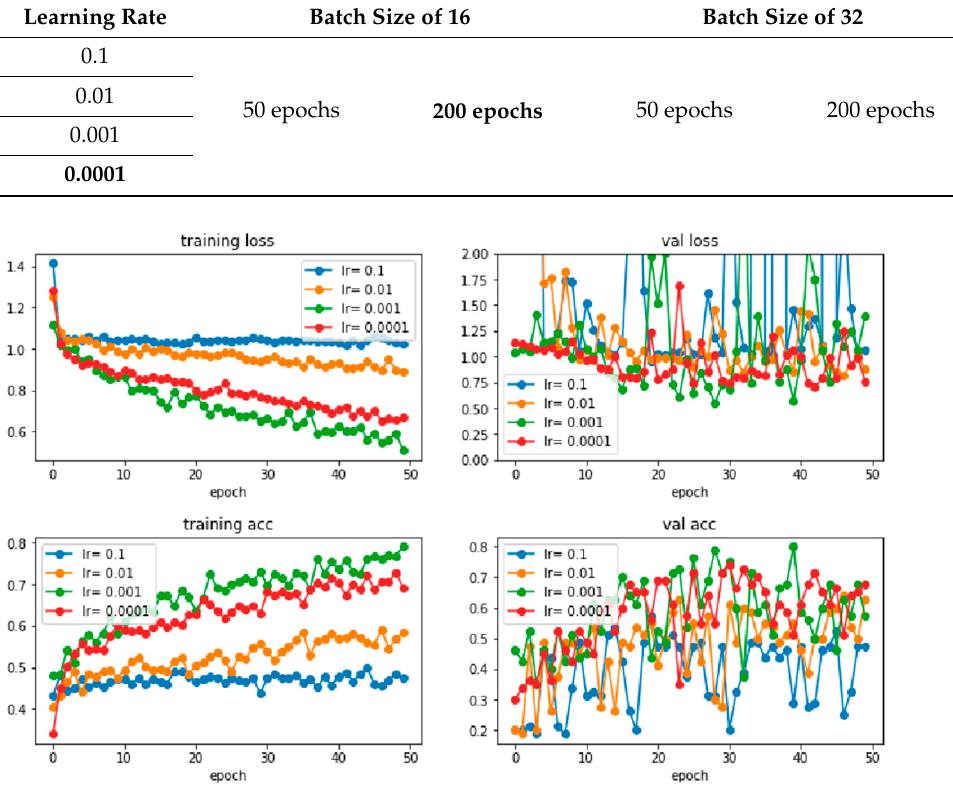
Table 3. Testing of the ResNet-like model with different hyperparameters using dataset with more images. The numbers in bold number are the hyperparameters discovered to build the ResNet-like model in this system.